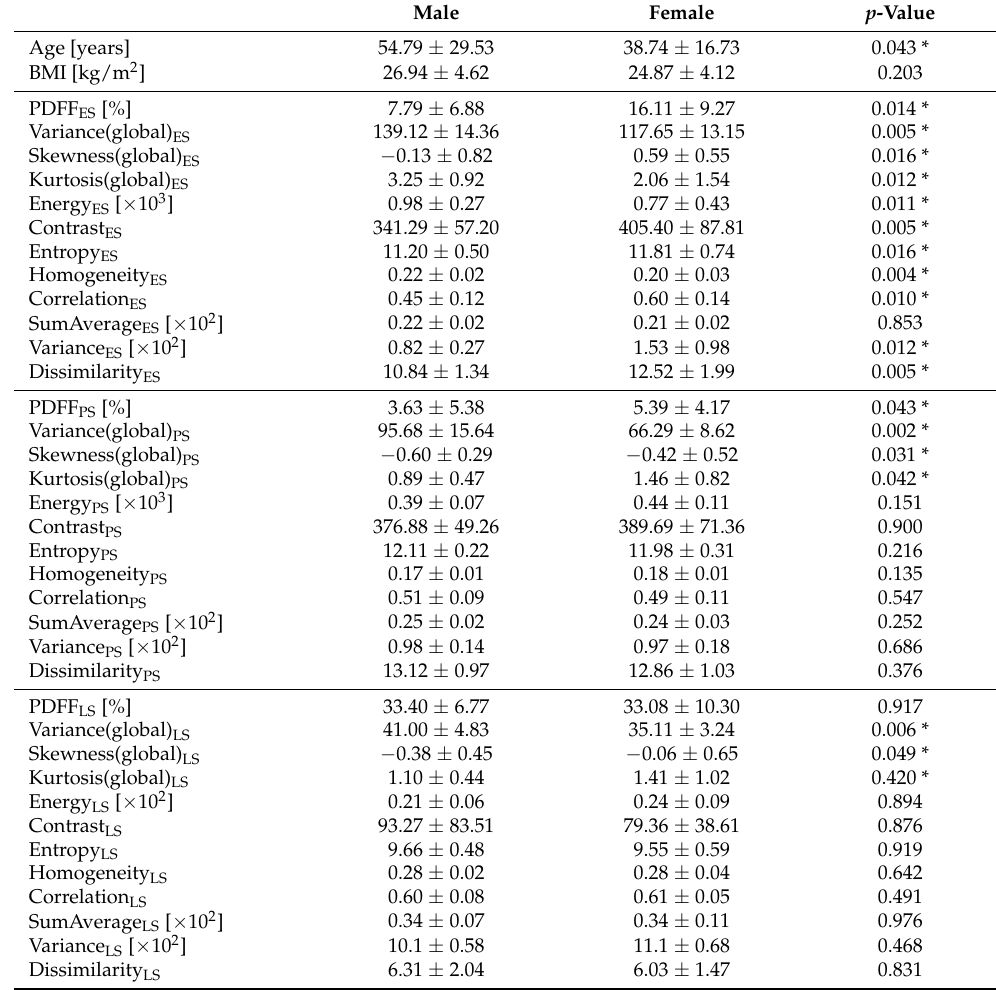
Table 1. Subject characteristics (age and BMI), PDFF and analyzed texture features for erector spinae (ES) and psoas (PS) muscles as well as the lumbar spine (LS) for all subjects (male, n = 13; female, n = 31). The p -values are the result of logistic regression analysis comparing the measurements of male and female subjects, adjusted for BMI and age; significant p -values (for an alpha level <5%) are indicated by an